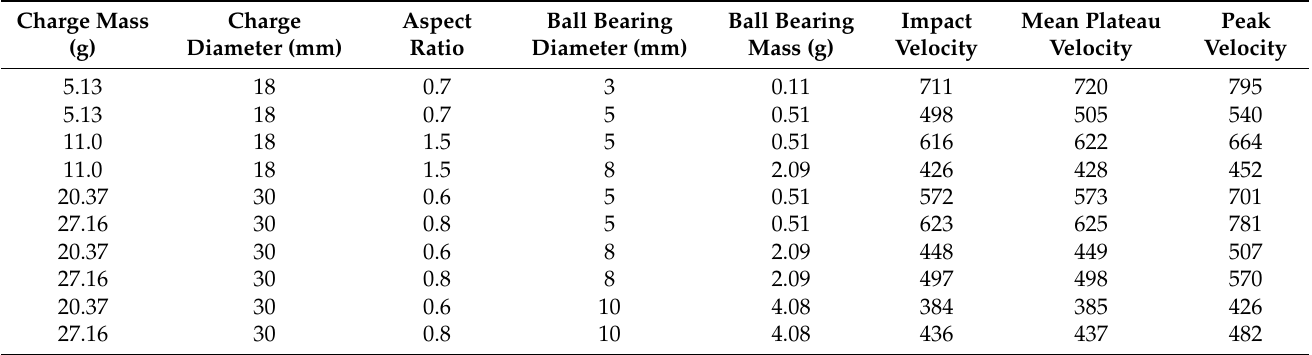
Table 4. Summary of flight characteristics obtained from the velocity simulations using different diameter ball bearings and charge